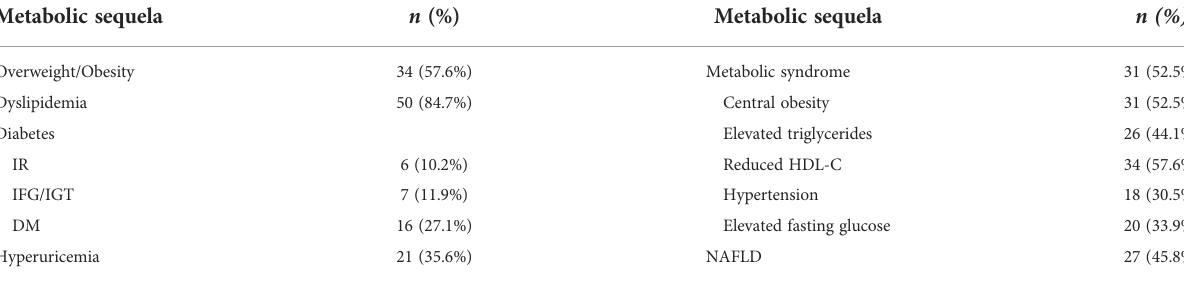
TABLE 4 Metabolic sequela of adults with hypothalamic dysfunction ( n =59).